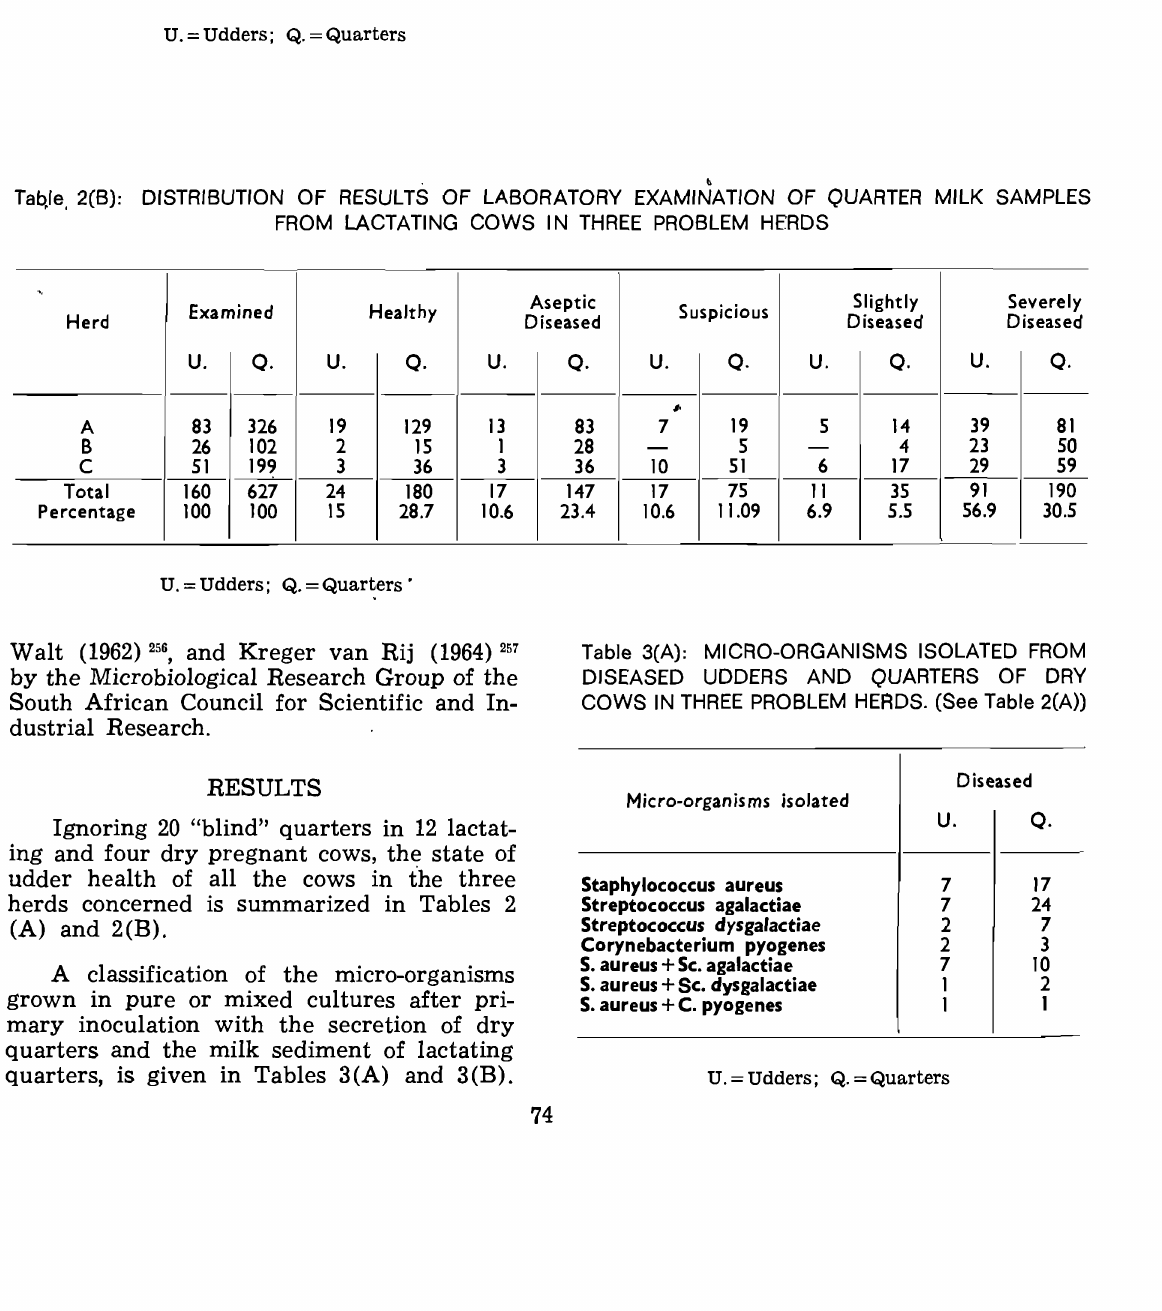
Examined Healthy Diseased Herd U. O. U.